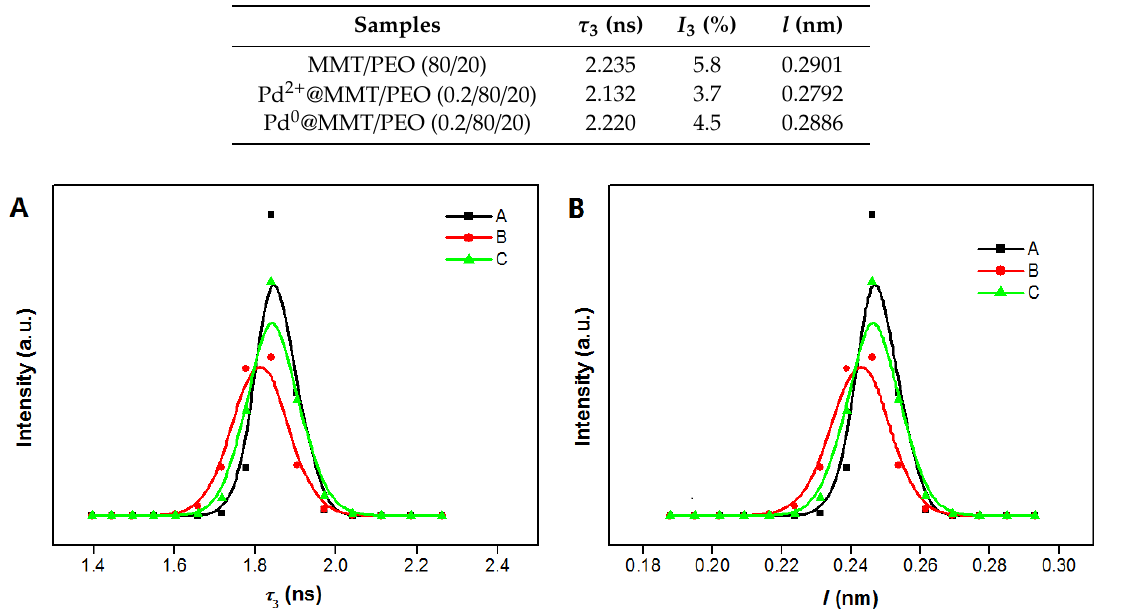
Table 2. Variation of longest lifetime, intensity, and mean size of micro-defects of the samples analyzed by LT-9 program.